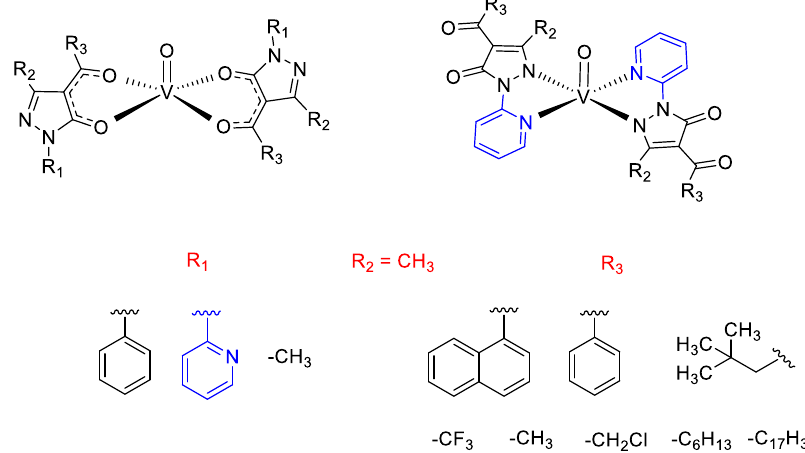
Figure 5. Structures of oxidovanadium complexes based on 4-acylpyrazolones ligands whose catalytic activity has been studied by our research group.